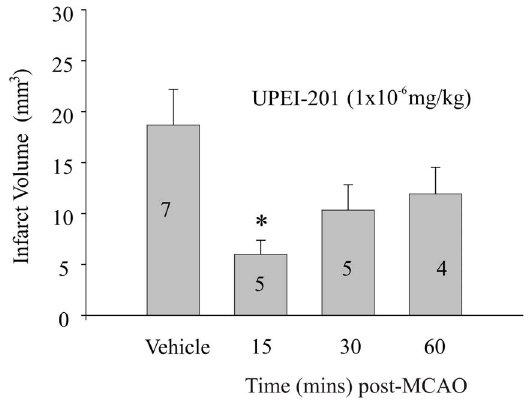
Figure 8. Time course of the effect of UPEI-201 on infarct volume. (A) Bar graph illustrating the effect on infarct volume of UPEI- 201 (1:1 ratio of lipoic acid to resveratrol) at a dose of 1 6 10 2 6 mg/kg or a vehicle (propylene glycol 4 6 10 2 3% (v/v)) injected during the occlusion (15) or at 30 minute intervals immediately following reperfusion. Each bar represents the mean 6 S.E.M. (n=5–7/group) and * indicates significance ( p # 0.05) from the vehicle-treated control group.